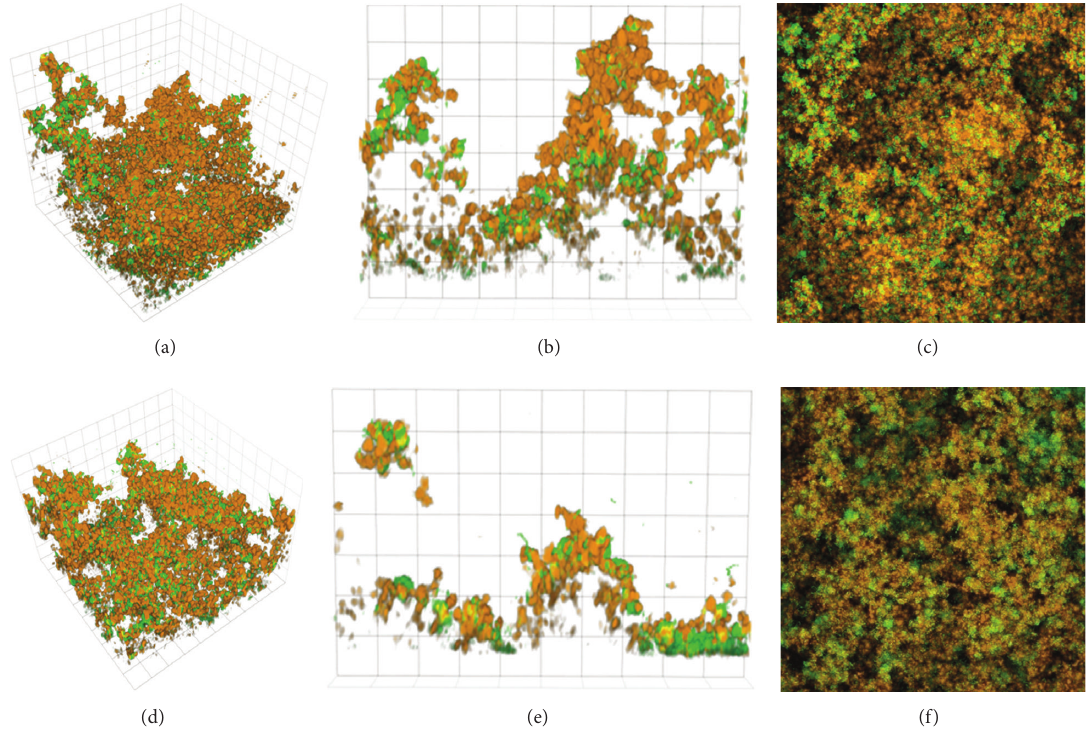
Figure 7: Representative images of sterile water treated S. mutans biofilms ((a), (b), (c)) and xylitol solution treated S. mutans biofilms ((d), (e), (f)). Alexa Fluor 647 Dextran Conjugate stain (carbohydrates) is represented in orange. Syto 9 stain (nucleic acids) is represented in green. Figures (a) and (d) depicted 3D tilted side views and (b) and (e) show 3D side slice view (10 𝜇 m). Figures (c) and (f) showed top to botton views of 2D extended focus views.